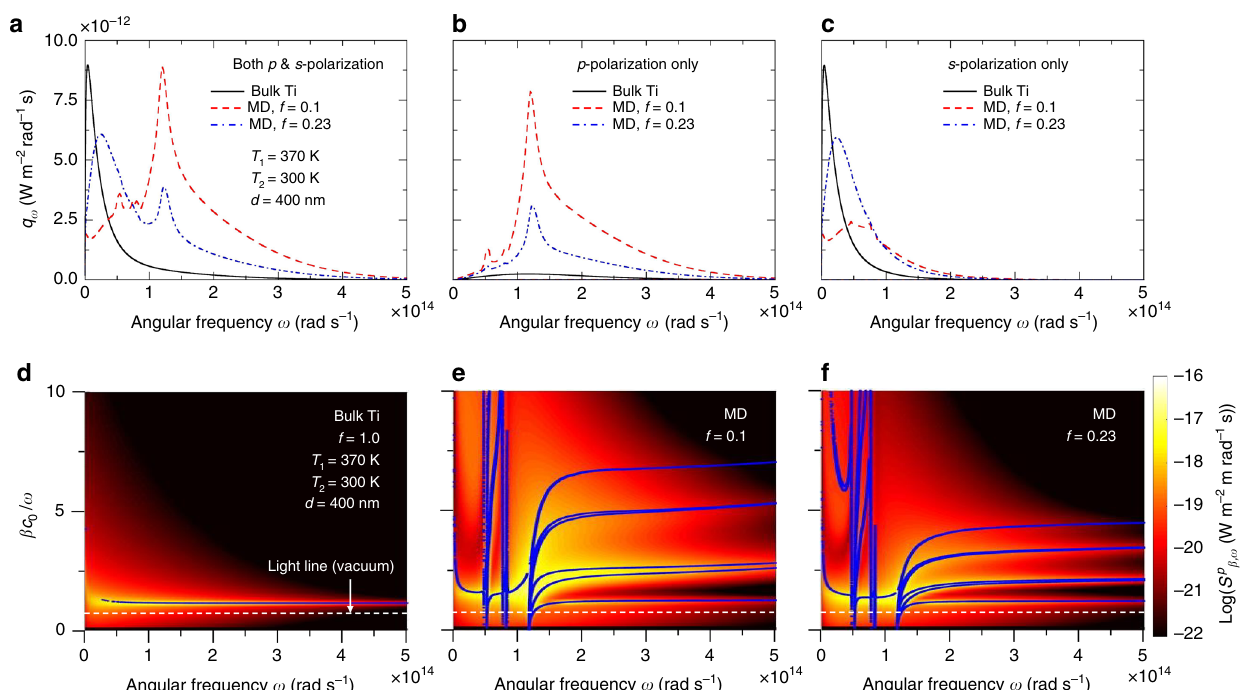
Fig. 5 Investigation of manipulated near- fi eld radiative heat fl ux by modifying surface condition with MD multilayers. a Computed spectral heat fl ux between Ti/MgF 2 multilayers ( f = 0.1 and 0.23) and bulk Ti media ( f = 1) at vacuum gap distance of 400 nm. The temperatures of the emitter and receiver are set to 370 K and 300 K, respectively. b , c As in a , but for p -polarized and s -polarized spectral heat fl ux, respectively. d Computed S p β ; ω between bulk Ti media for vacuum gap distance of 400 nm and temperature of emitter and receiver conditions described in a . A larger value of S p β ; ω is observed along the plotted SPP dispersion curve. e , f As in d , but between MD multilayers, which have volume fi lling ratios of 0.1 and